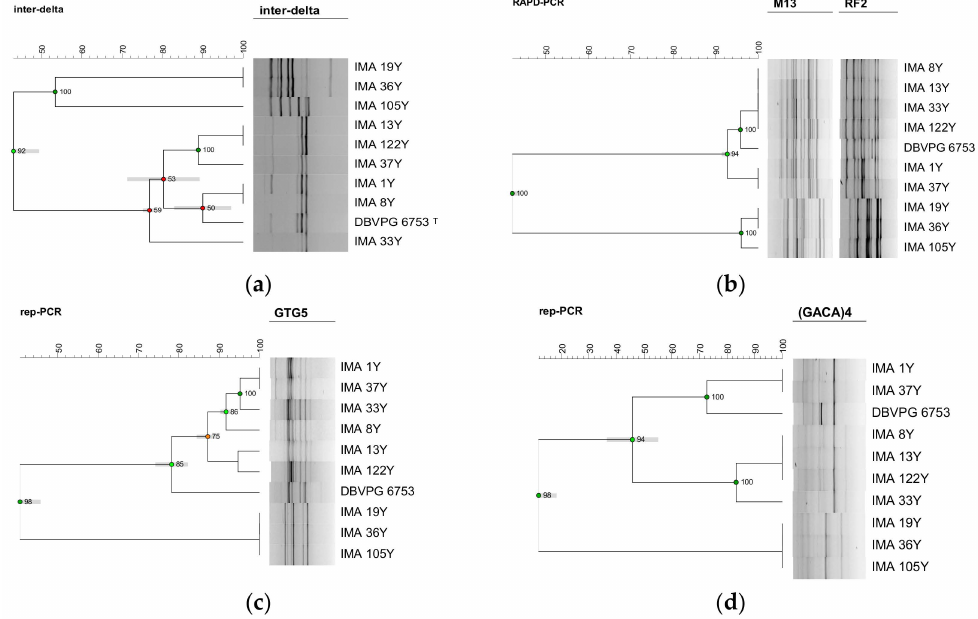
Figure 3. Screening of the best discriminating tool carried out on 10 selected yeast isolates characterizing PDO Tuscan bread sourdough. Dendrogram obtained from UPGMA analysis, using Dice’s coe ffi cient, of inter-delta profiles ( a ), RAPD-PCR profiles, obtained using M13 and RF2 primers ( b ), (GTG) 5 ( c ) and (GACA) 4 ( d ) rep-PCR profiles. The scale indicates the similarity level. Cophenetic correlation is shown at each branch by numbers and coloured dots, ranging between green-yellow-orange-red, according to decreasing